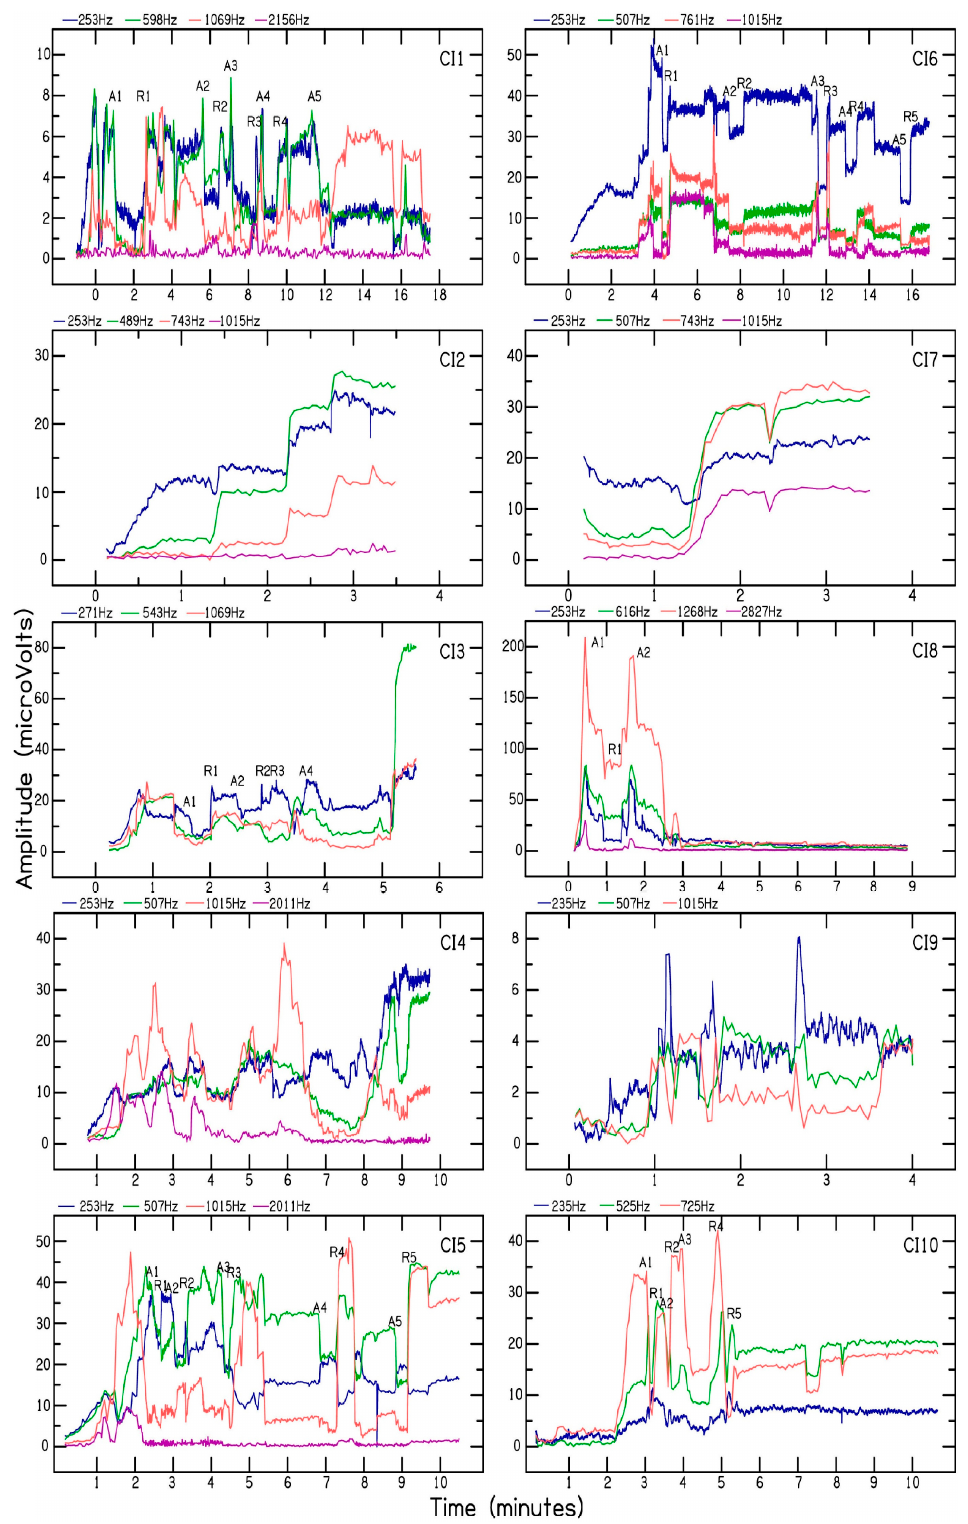
Figure 2. Intraoperative multi-frequency CM tracings measured for ten cochlear implant patients. The abscissa shows time (min) and the ordinate shows CM amplitude ( µ V). The frequencies used to elicit CMs are shown above each